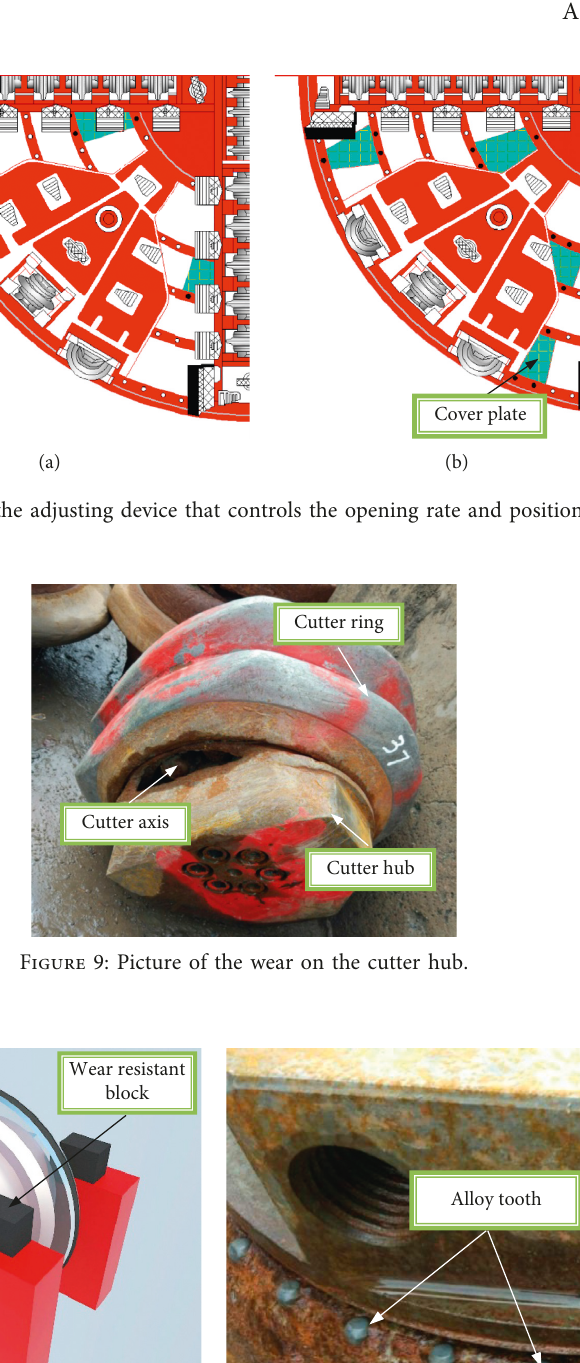
Figure 10: Schematic diagram of the hub protection